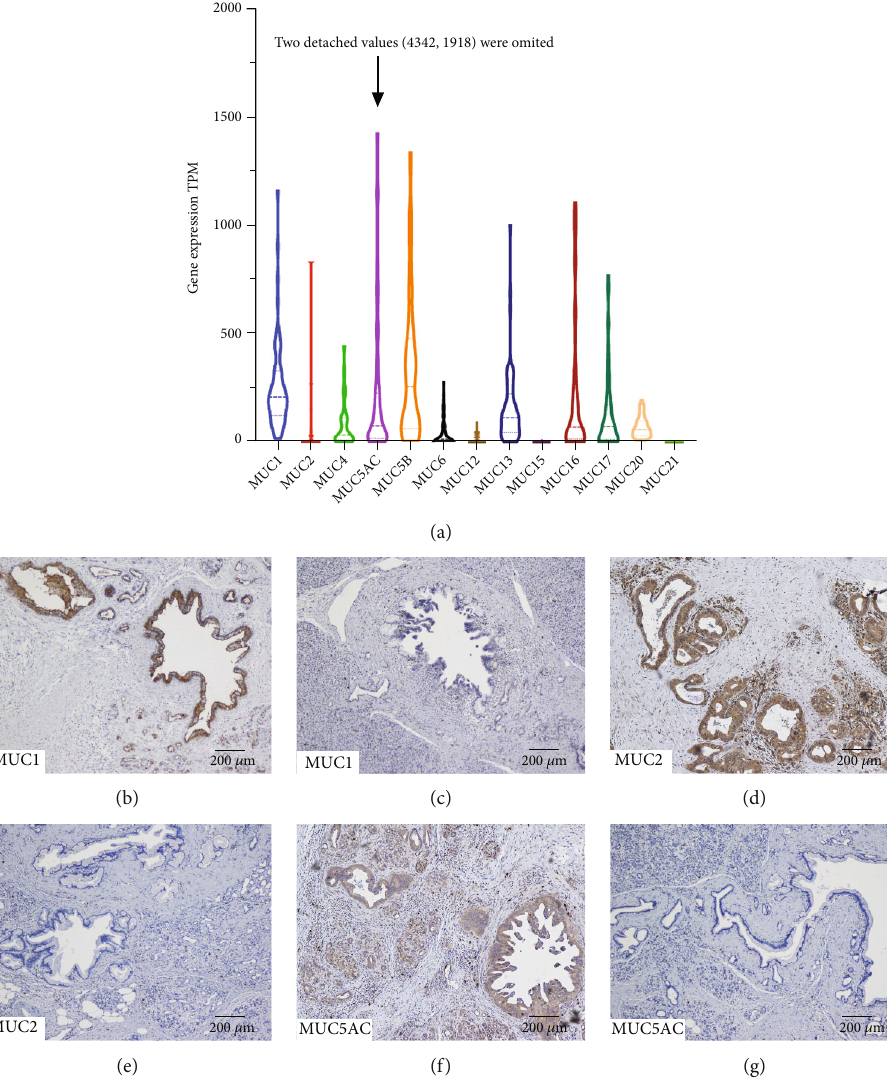
Figure 1: The expression patterns of mucins in PDAC tissues. (a) mRNA expression level of mucins in the QCMG PDAC cohort ( n = 70 ). (b – g) Low-power- fi eld images showing the representative positive and negative results of IHC staining mucins ’ expression in the FUSCC PDAC cohort. Corresponding high-power- fi eld images were displayed in Supplementary Figure 1. (b, c) MUC1-positive expression was only considered when positive coloration located in the apical membrane of PDAC cells; (d, e) MUC2-positive expression was only considered when positive coloration was located in the cytoplasm of PDAC cells. (f, g) MUC5AC-positive expression was only considered when positive coloration was located in the cytoplasm of PDAC cells. Abbreviations: TPM: transcripts per million reads; PDAC: pancreatic ductal